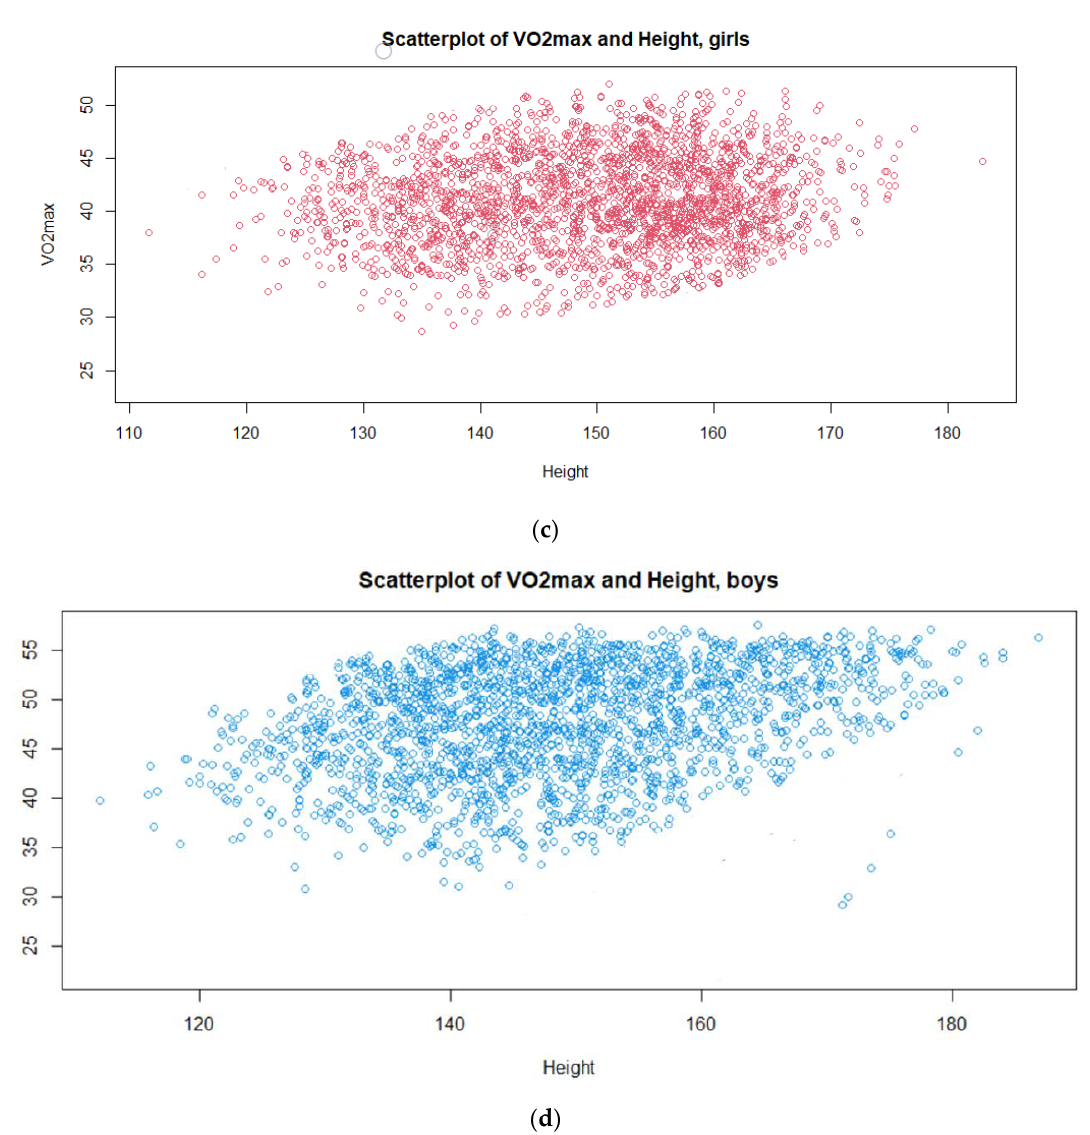
Figure 4. Scatterplots between VO 2 max and two continuous variables, weight ( a ) girls and ( b ) boys and height for ( c ) girls and ( d ) boys.